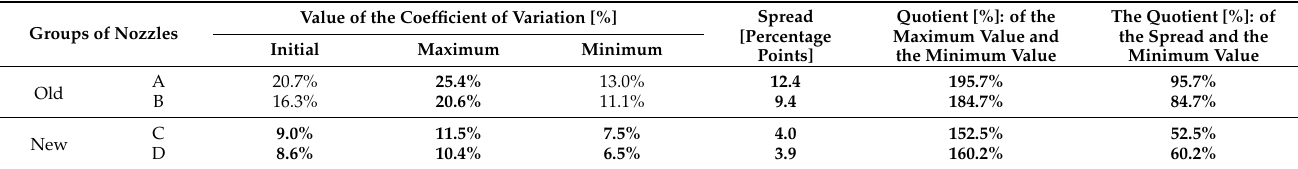
Table 2. The value of the coefficient of variation [%] for groups A–D on tables with 0.1 m wide grooves, depending on the sequencing and method of mounting flat fan nozzles on the boom of a field